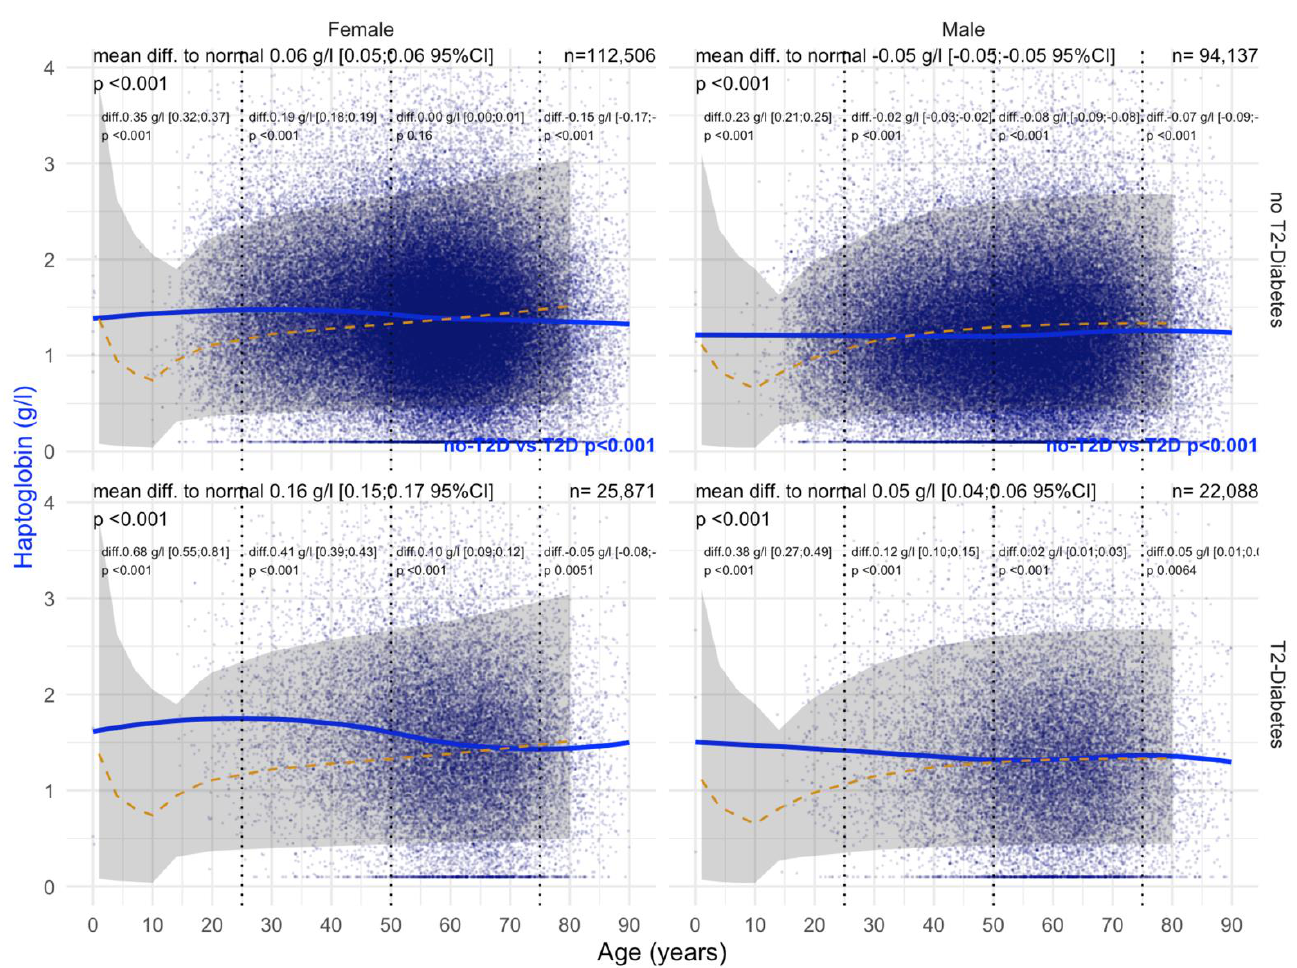
Figure 16. Haptoglobin levels before the COVID-19 pandemic. Impact of T2DM on Hapto concentration before SARS-CoV-2 pandemic in “NAFLD-Serum” patients followed for metabolic liver risk (n = 254,602). Normal serum means values according to age and sex (dashed–orange lines), with 95% confidence intervals (gray ribbon). Three vertical–dotted lines mark the four age groups (before 25, between 25 and 50, between 50 and 75, and above 75 years old). The blue curve is a Loess regression of the median of Hapto values. For each age group, the mean difference (%95CI) between the patient protein value and the expected normal value (for age and sex) with its significance p -value is displayed at the top of the figure. The significance between the non-T2DM and T2DM patients is displayed in blue between the 2 panels.